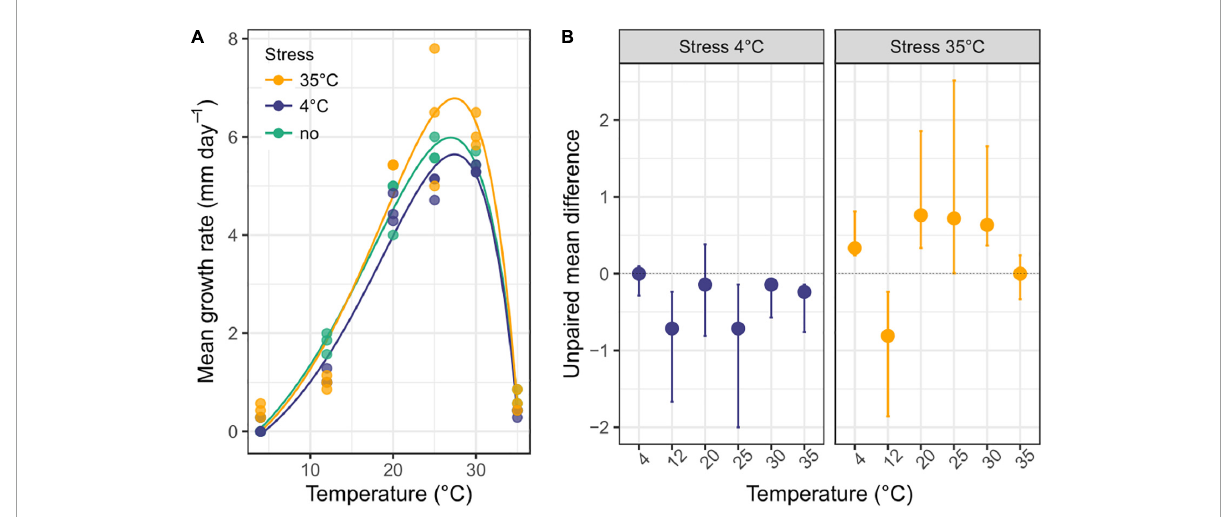
FIGURE5 Thermal reaction norm of Sphaeropsis sapinea previously exposed or not to a temperature stress. (A) Mean growth rate ( n = 3) of S. sapinea on 1.5% MAE across temperature without prior temperature stress or with a prior 4 ◦ C and 35 ◦ C temperature stress. The curve depicts the thermal reaction norm model fitted to the data. Parameter estimates of the thermal reaction norm are reported in Table 1 . (B) Effect size (unpaired mean difference) and bootstrapping 95% confidence interval of prior temperature stress exposure on growth rate compared to when the fungus was not exposed to prior temperature